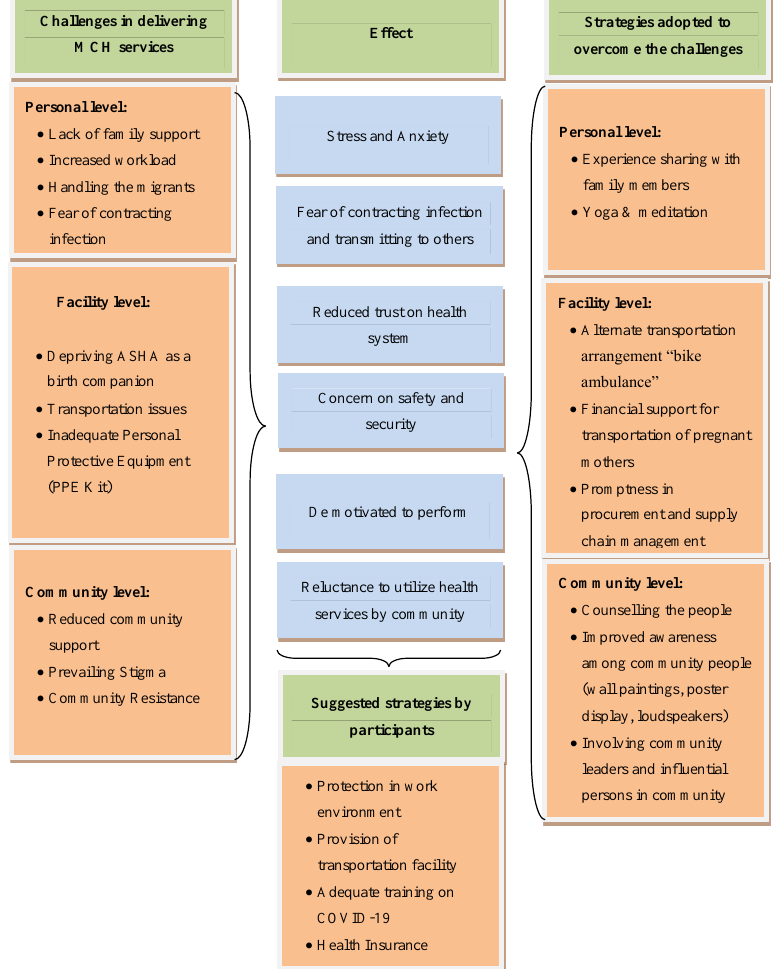
Figure 2. Conceptual framework depicting the challenges faced, their effect, and strategies adopted by CHWs.